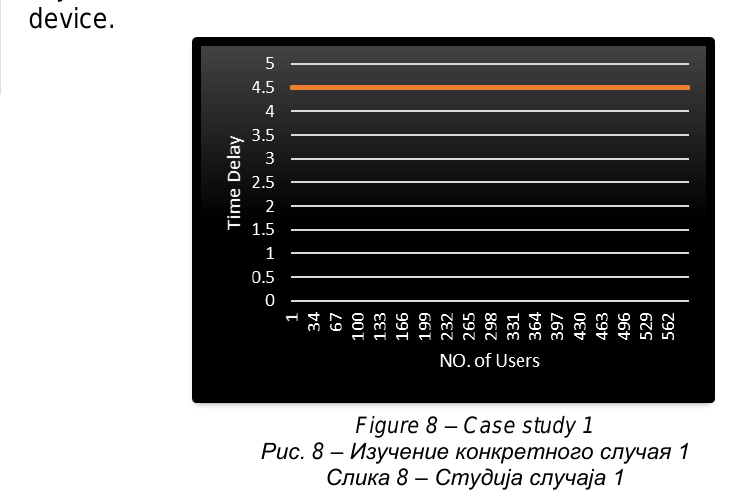
Рис. 8 – Изучение конкретного случая 1 Слика 8 – Студија случаја 1